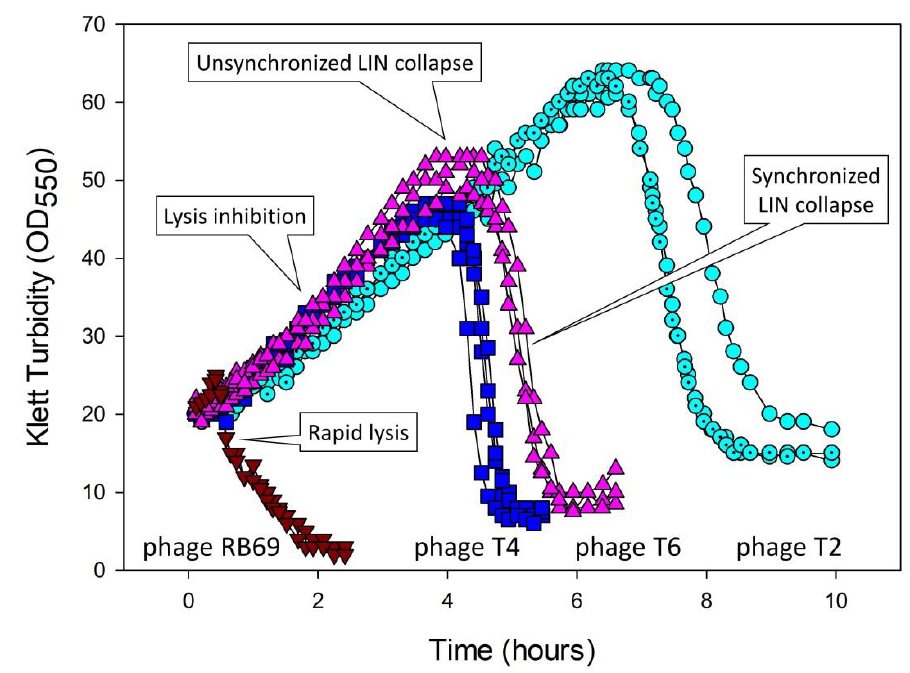
Figure 2. Examples of phage myovirus lysis profiles. Shown, left-to-right, are phage RB69 (brown, inverted triangles, and which does not display LIN but instead rapid lysis) along with the LINed phages T4 (blue squares), T6 (pink triangles), and T2 (aqua circles), with each curve generated from a phage stock obtained from a different source. The three stocks of phage T2 were designated as simply T2 (leftward circles), T2L (circles with center dots, also found to the left), and T2H (rightward circles). E. coli CR63 was employed as the host, with an initial density of approximately 10 8 colony-forming units/mL. Phages were applied only once, at time zero, with a multiplicity of 10. A similar lysis profile to that of phage RB69, but by the phage T4 rI mutation, r 48, is published in Paddison et al. [30]. Synchronized LIN collapse for phages T2, T4, and T6 is observed as rapid, that is, steep declines in culture turbidities. This contrasts with an unsynchronized LIN collapse, which can be observed just prior to the start of synchronized LIN collapse. Unsynchronized LIN collapse can instead occur over longer periods by adding anti-virion agents such as anti-virion serum to an LINed culture prior to or even following the start of their LIN collapse, or by initiating LINed cultures using phages which are unable to release intact virions [18] (these latter experiments are not shown in the figure). With only unsynchronized LIN collapse, culture-wide lysis thus can occur over the course of an hour or more, and this is rather than the minutes as seen here especially with phages T4 and T6, where LIN collapse instead is synchronized [18] (the longer duration of LIN collapse observed with phage T2 in the figure I speculate could be due to depletion of nutrients in the cultures stemming from the long span of phage T2’s LIN prior to that collapse, as addition of nutrients, specifically casamino acids, to highly turbid T4 cultures during broth stock preparation can result in more efficient lysis of those stocks [62]). Note that the observed rise in turbidity following phage application is not due to significant bacterial division, i.e., as considered further below (Figure 6), but instead presumably is due to increases in the turbidity associated with individual phage-infected bacteria [63,64]. This experiment was originally published in Abedon et al. [17], with the figure redrawn for presentation here. The phenotype of particular interest in Hershey’s 1946 publication [8] was that of plaque morphology. The plaques of these r mutants Hershey described as having a (p. 623), “…somewhat larger size, which differ [from wild type] in showing nearly complete lysis at the periphery.” That is, wild-type phages that display LIN have smaller plaques which are cloudy in their periphery, what Hershey [8] describes as “a distinct halo of partial lysis”. Typically, wild-type plaques displaying LIN are also described as having rougher edges (less sharp) in comparison with the plaques of r